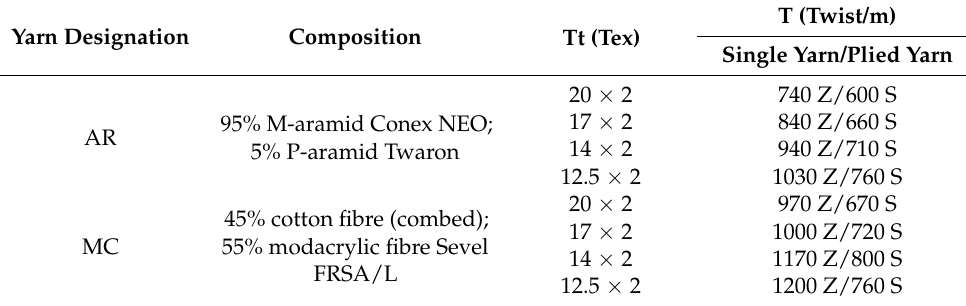
Table 1. Declared parameters of the